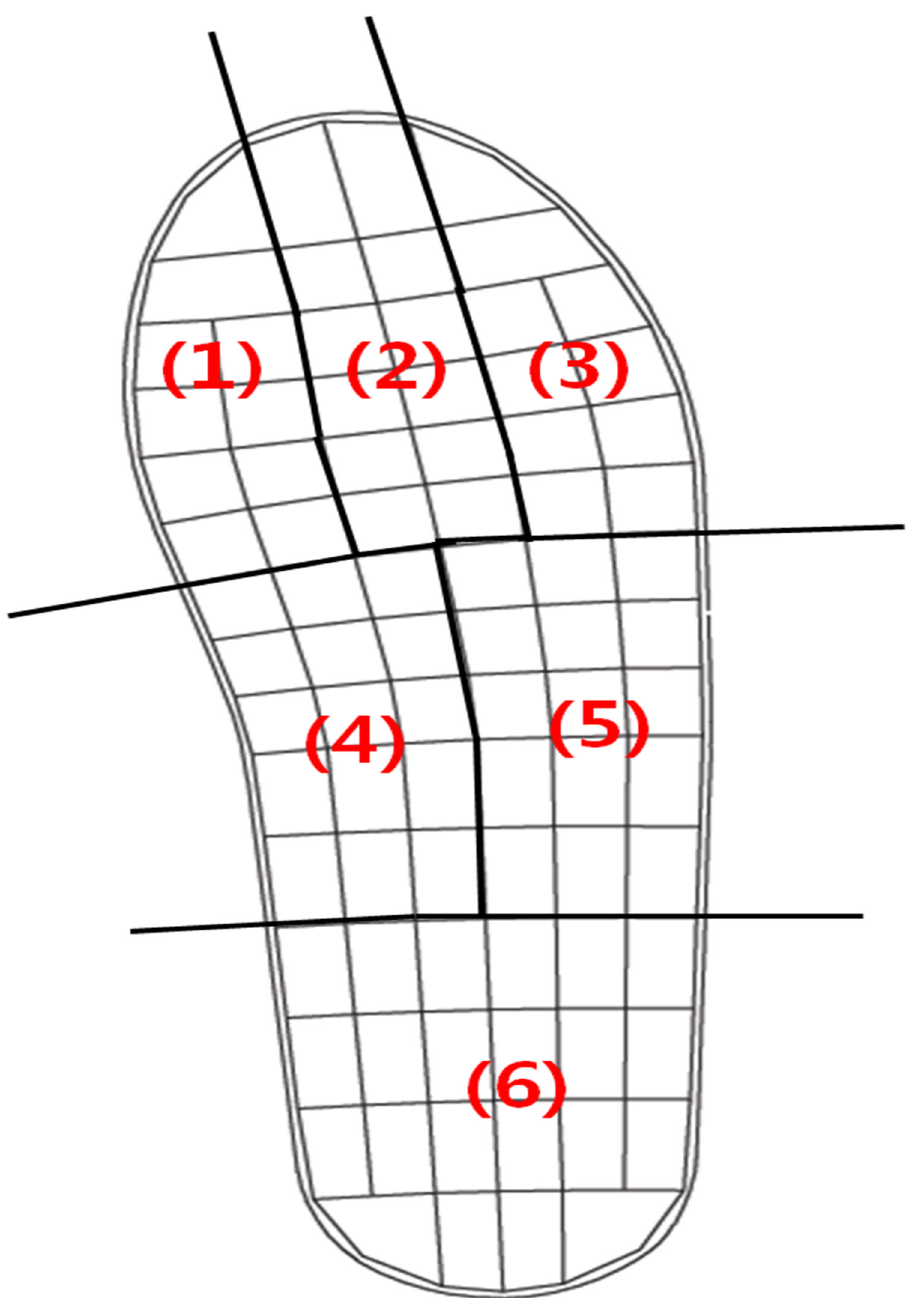
Fig 2. The 6 mask areas of the foot. (1) Medial forefoot, (2) central forefoot, (3) lateral forefoot, (4) medial midfoot, (5) lateral midfoot, (6) rearfoot.